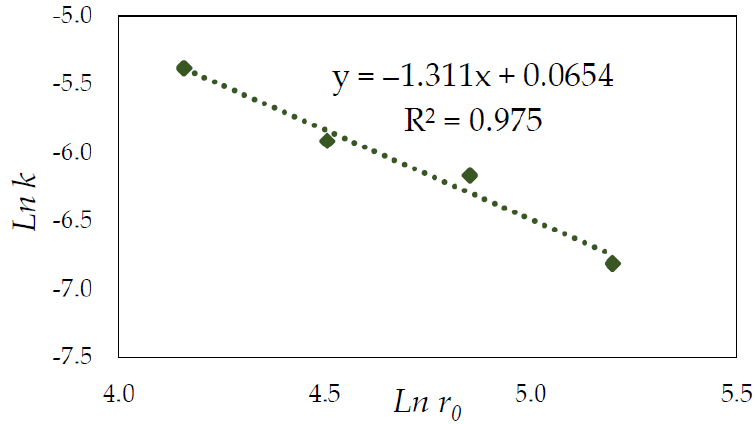
Figure 13. Plot of lnk as a function of ln ( r 0 ).